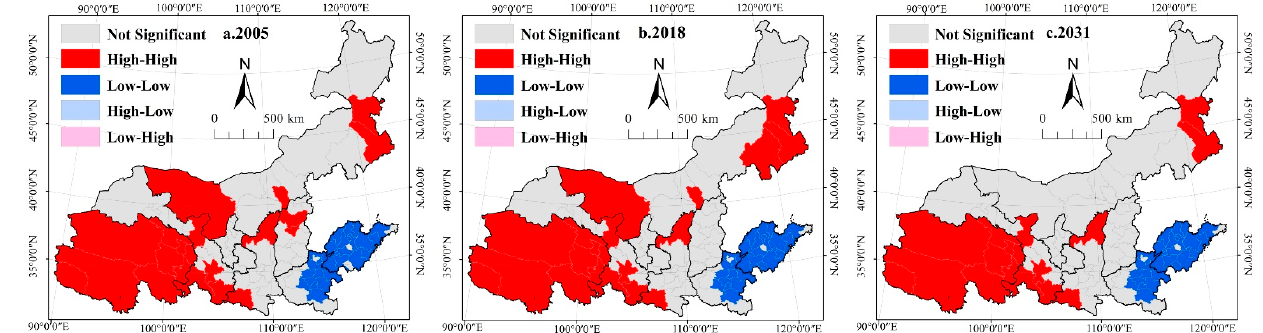
Figure 4. LISA cluster map of habitat quality in the Yellow River Basin. ( a ). 2005 represents the LISA cluster map of habitat quality of the Yellow River Basin in 2005; ( b ). 2018 represents the LISA cluster map of habitat quality of the Yellow River Basin in 2018; ( c ). 2031 represents the LISA cluster map of habitat quality of the Yellow River Basin in 2031.